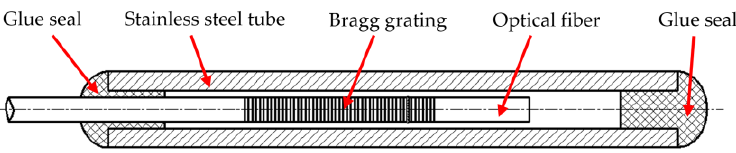
Figure 4. Encapsulated FBG for temperature measurement.